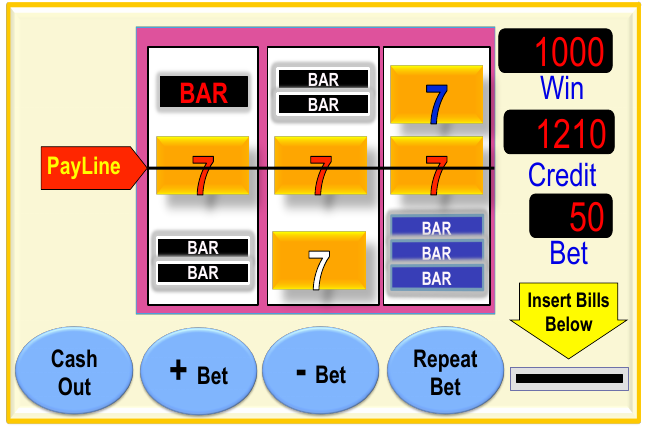
Figure 24. Example of slot machine.